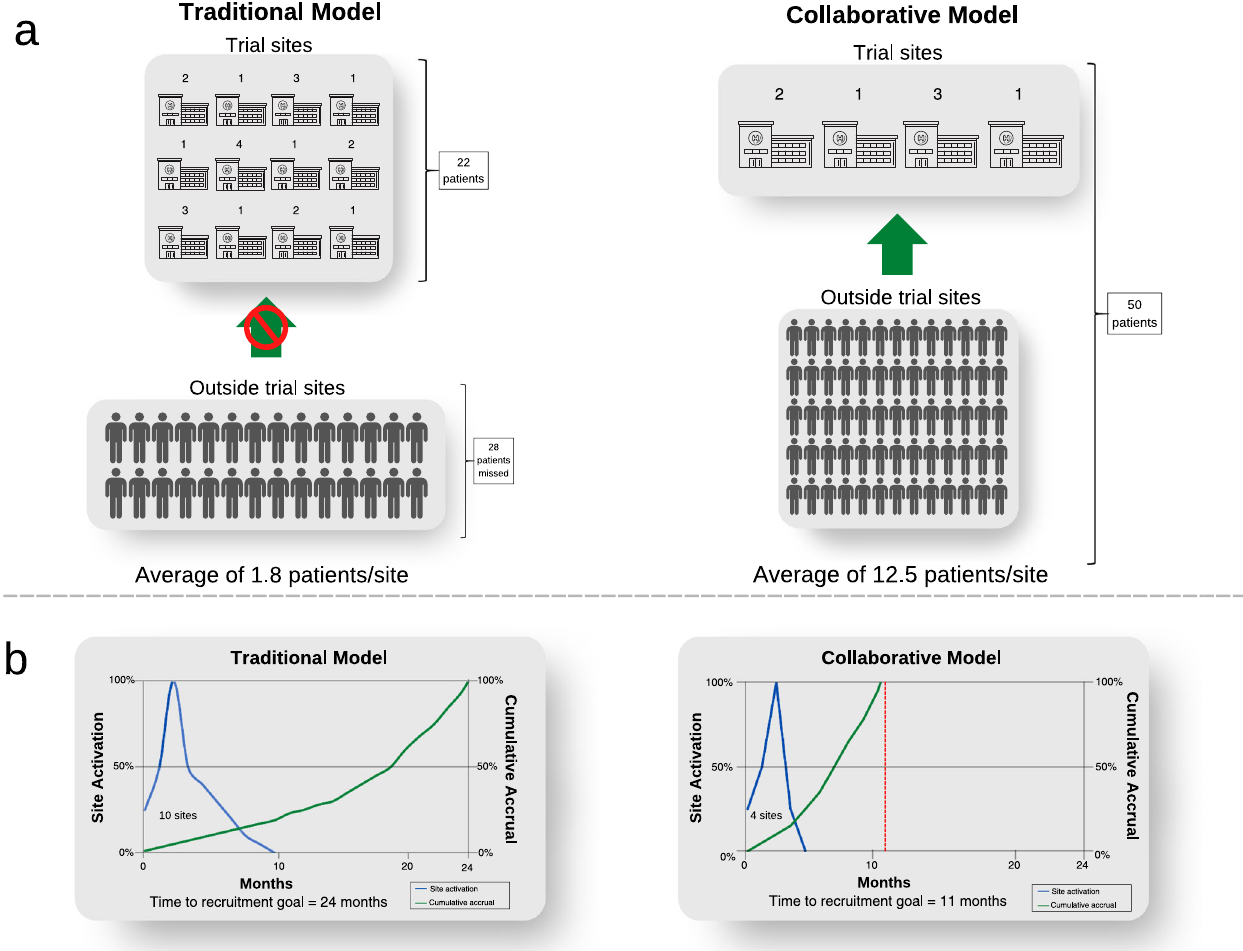
Fig. 4 Increased trial ef fi ciency due to shift from site-based to population screening. a Screening and trial sites for clinical trials by model. The numbers above each institution represent eligible patients for a biomarker dependent trial. b Differences in ef fi ciency for trial recruitment between models. ©[Visual Generation, Pixeden] via